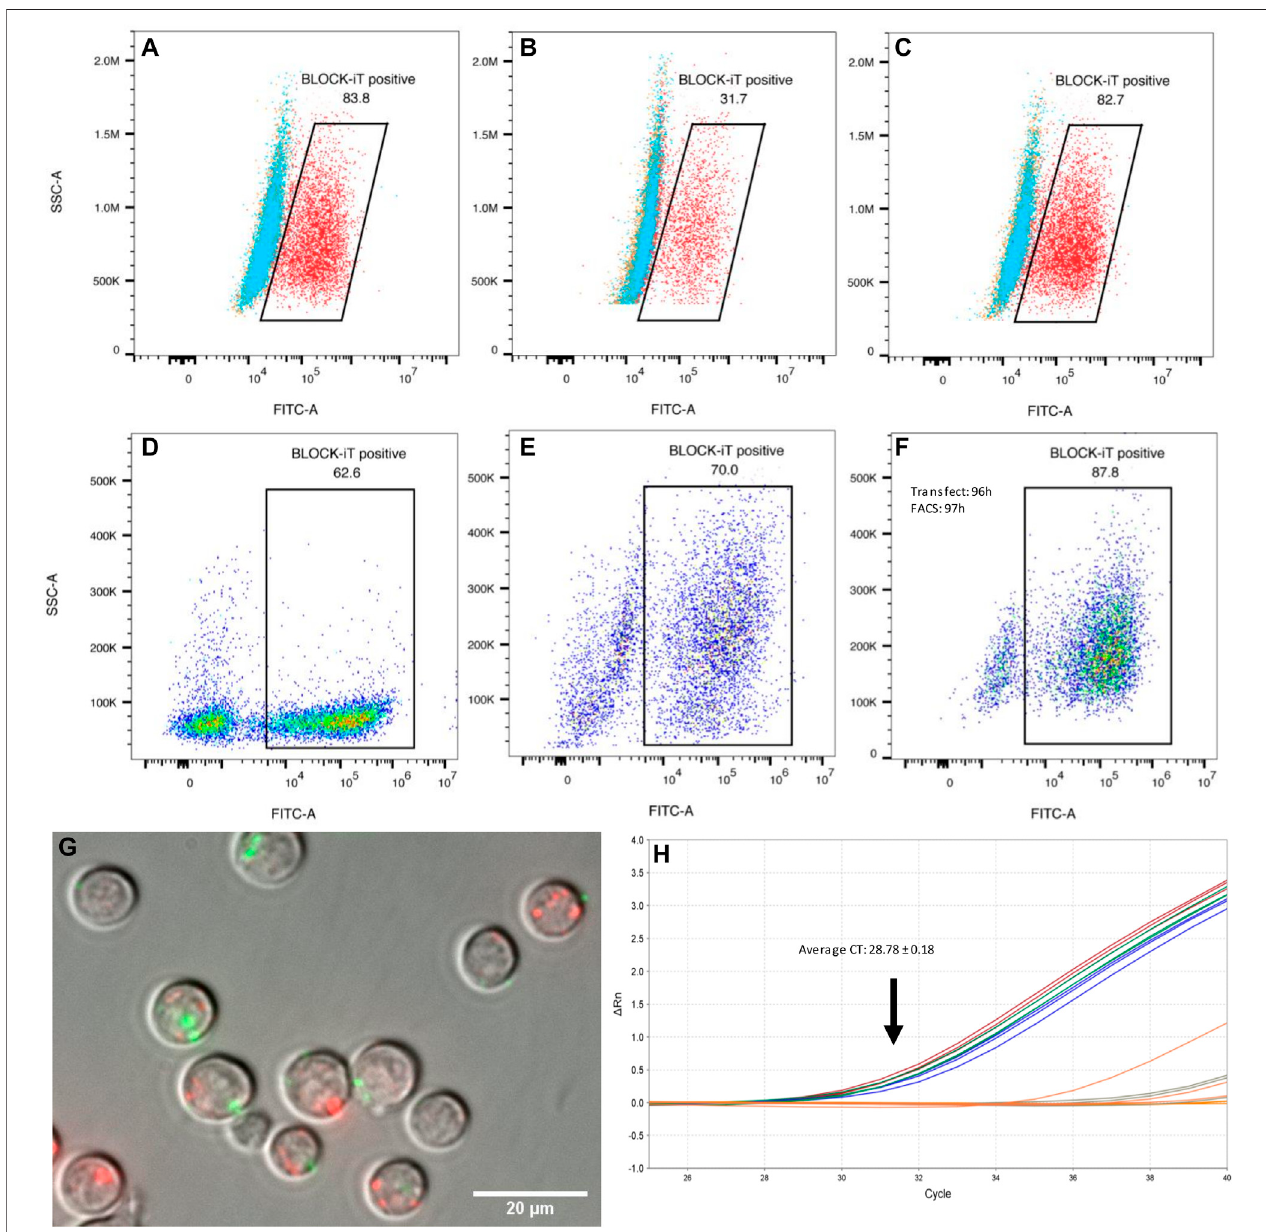
FIGURE 3 | Transfection ef fi ciency. (A – C) Raw 264.7 macrophages (m ϕ ) transfected with a fl uorescent oligonucleotide (representative examples). (A) 83.8% of unpolarized macrophages showed FITC fl uorescence 1 h post transfection with BLOCK-iT fl uorescent oligonucleotide (FITC labeled) and lipofectamine (red). Cells exposed to the oligo only are shown in blue, or to the transfection reagent only, in orange. (B) Classically activated macrophages (M1) showed only 31.7% transfection ef fi ciency with the fl uorescent oligo and lipofectamine (red). (C) Alternatively activated macrophages (M2) showed a high transfection ef fi ciency, similar to M0 cells, with 82.7% cells showing FITC labeling. Transfection ef fi ciency in differentiating Th2 cells (D – F) . CD4 + naïve T cells were transfected with BLOCK-iT fl uorescent oligo upon start of the differentiation protocol (day 0). Transfection ef fi ciency was measured after 1 h (D) and again after 48 h (E) . Cells transfected at the end of the differentiation protocol (96 h) showed 87.8% of FITC-labelled cells when the oligo was introduced into cells with lipofectamine (F) . (G) Live cell imaging of transfected differentiatingTh2cells.CD4 + Tcellsweretransfectedat96 hofTh2differentiationwithaFITC-labelledoligo(green)andimaged1 hpost-transfection(magni fi cation:60 x). Lysosomes were stained with Lyso-Tracker red DND-99 (red). There is a priori no co-localization between introduced oligonucleotides and lysosomes. (H) Real-time PCRampli fi cation ofHpo-miR-71-5p frommiRNA followingmouse AGOpull-downs, 4 hafter transfection ofTh2 cellswithmiRNA mimics.miRNA transfected samples are represented by blue, red, and green replicate